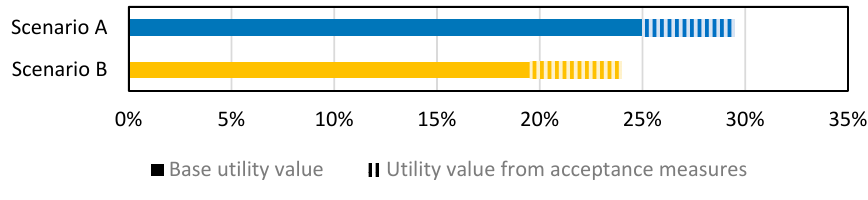
Figure 7. Weighted degree of objective achievement (partial utility values) for Scenarios A and B.